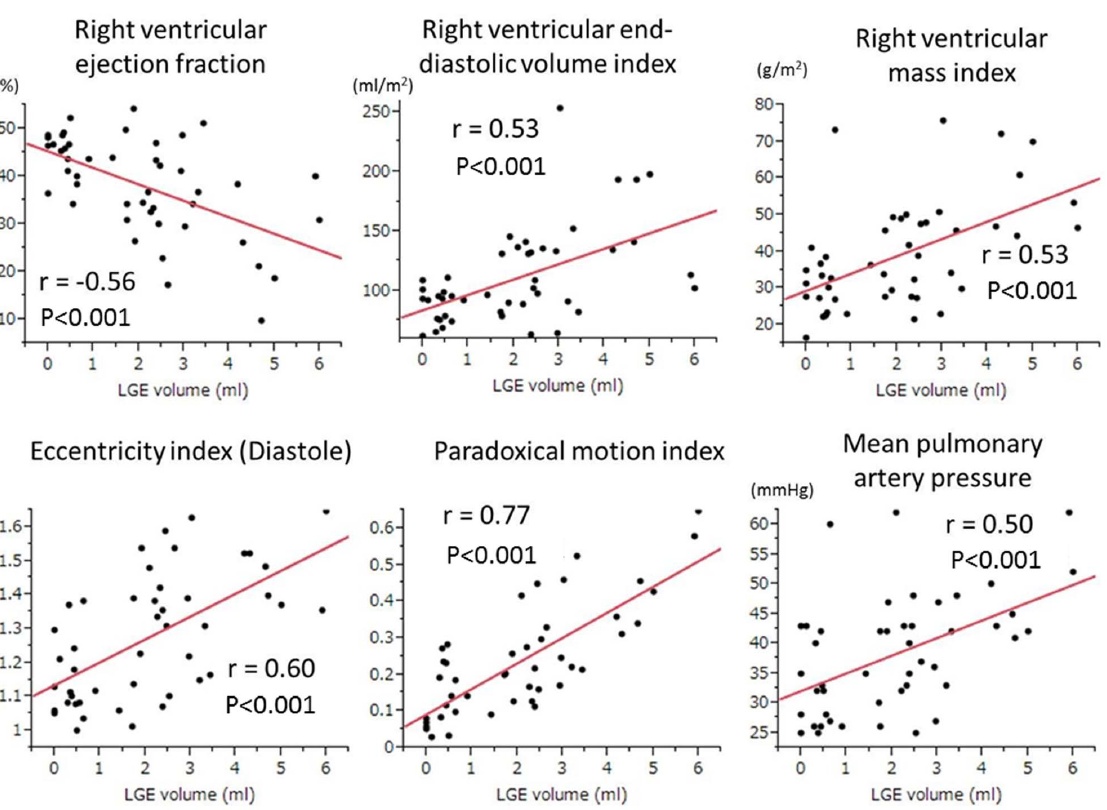
Figure 3. Relationships between late gadolinium enhancement volume at ventricular insertion points and other clinical parameters. Among the six clinical indices of pulmonary hypertension, the paradoxical motion index of the interventricular septum exhibited the highest correlation coefficient (r=0.77, p , 0.001) with late gadolinium enhancement volume.